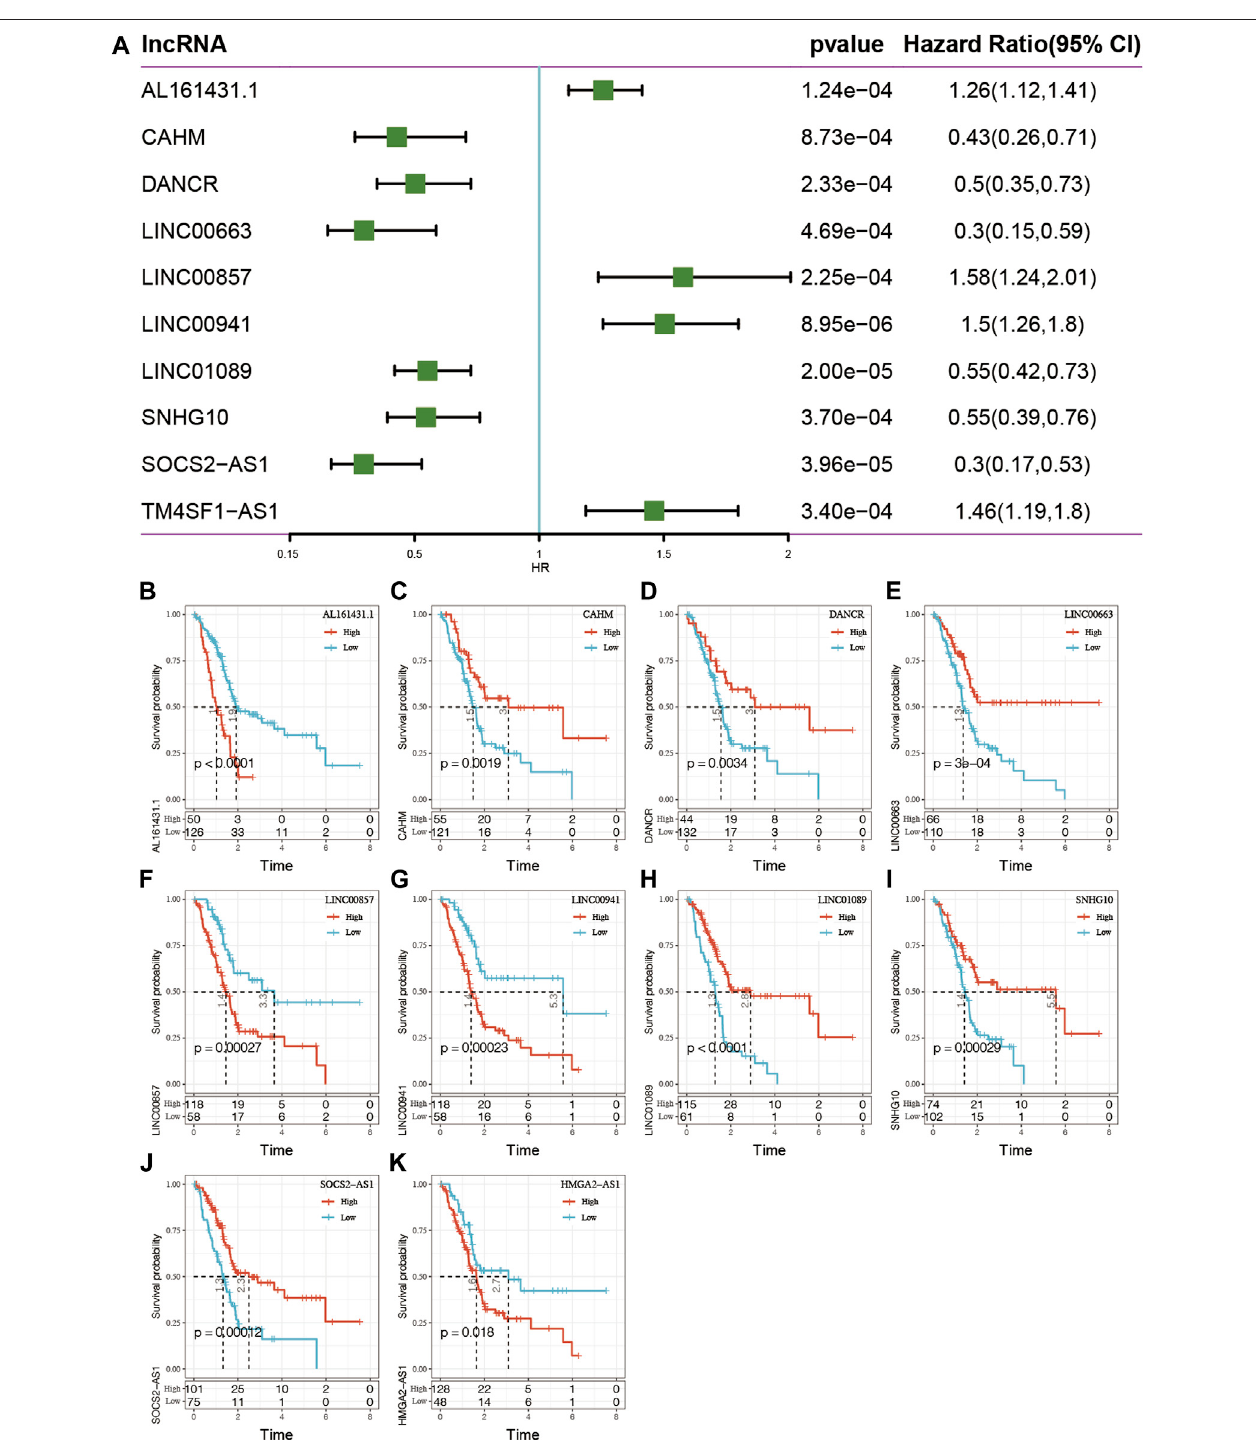
FIGURE 6 | (A) Single-factor analysis of 10 epi-lncRNA genes related to pancreatic cancer. (B – K) Survival curve analyses for the 10 genes.